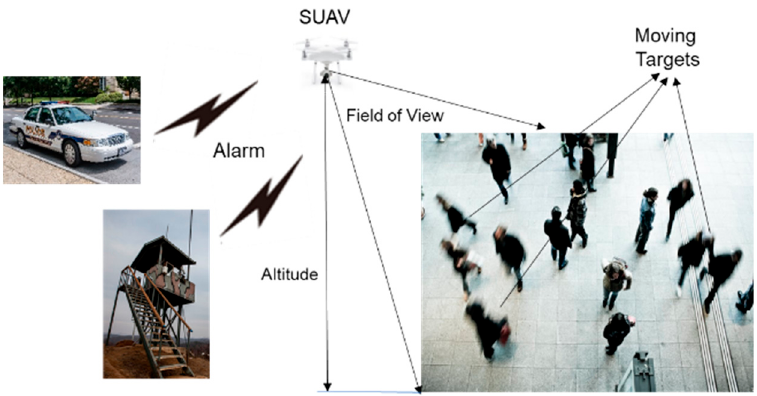
Figure 1. Illustration of aerial surveillance with a small unmanned aerial vehicle (SUAV).